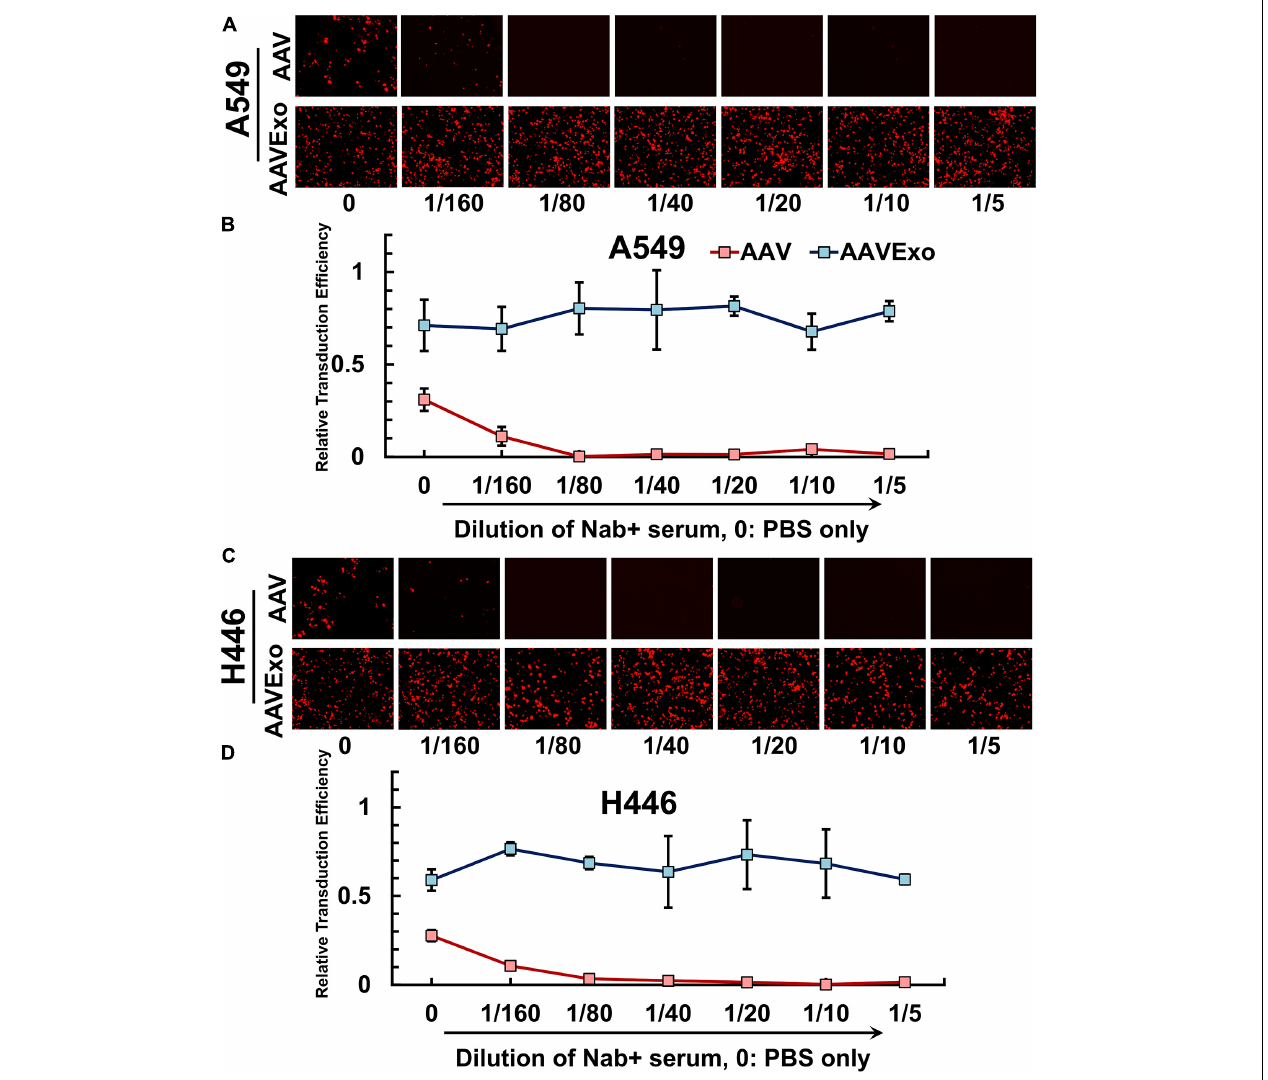
FIGURE 5 | AAVExo has excellence resistance to neutralizing antibodies in vitro . Dilutions (1/5–1/160) of Nab-positive serum or PBS were incubated with AAV6Exo-mCherry or AAV6-mCherry for 30 min. The mixture with equal titer of genome copy was added to the culture of (A,B) A549 or (C,D) H446, and cells were ready for imaging 3 days later. Fluorescence intensity was quantified and normalized to DAPI for compiled plotting. The plot showed the mean with the standard deviation for three biological